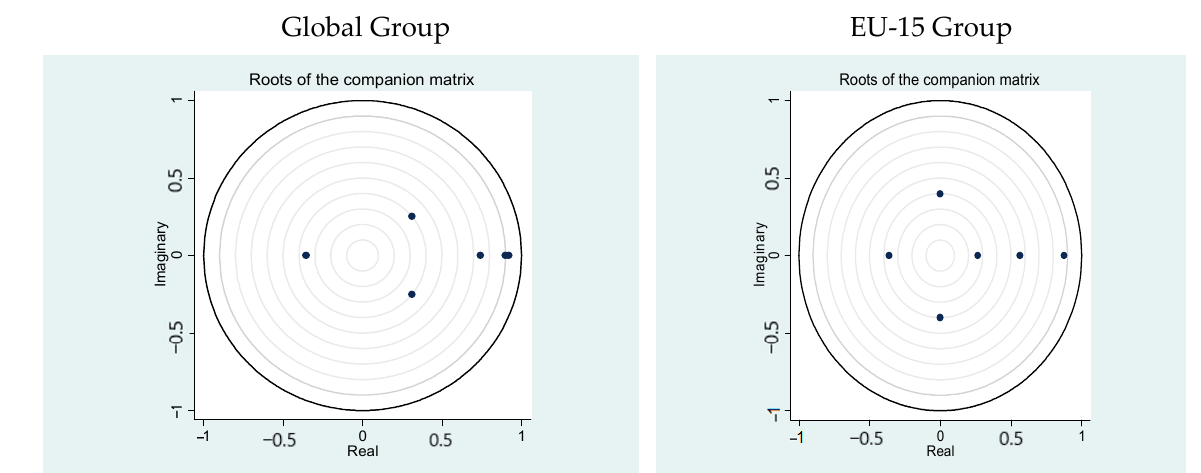
Figure 1. Eigenvalue stability